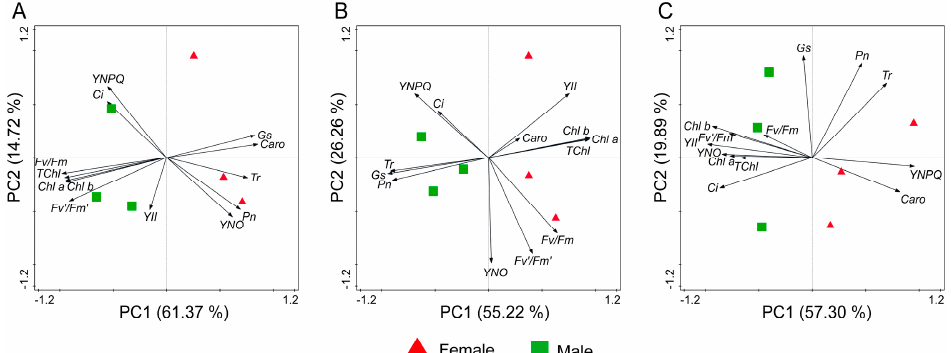
Figure 4. Principal component analysis (PCA) of leaf pigments, photosynthetic parameters, and chlorophyll fluorescence parameters of L. cubeba female and male leaves under treatments ( A ) P1, ( B ) P2, and ( C ) P3. CK, P1, P2, and P3 represent 0, 1, 2, and 3 mmol Pb/kg dry soil, respectively.